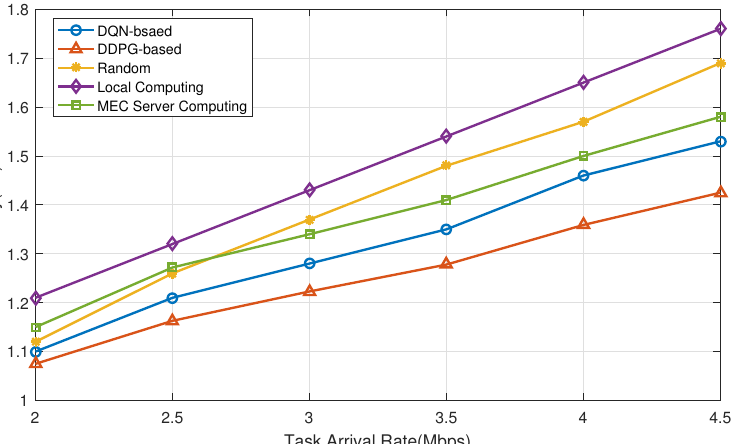
Figure 9. The delay comparison under different task arrival rates, where the red curve represents the delay of the DDPG-based computational offloading paradigm, the blue curve represents the delay of the DQN-based computational offloading paradigm, the yellow curve represents the delay of the “Random” policy, the purple curve represents the delay of the “Local computing” policy, and the green curve represents the delay of the “MEC server computing”